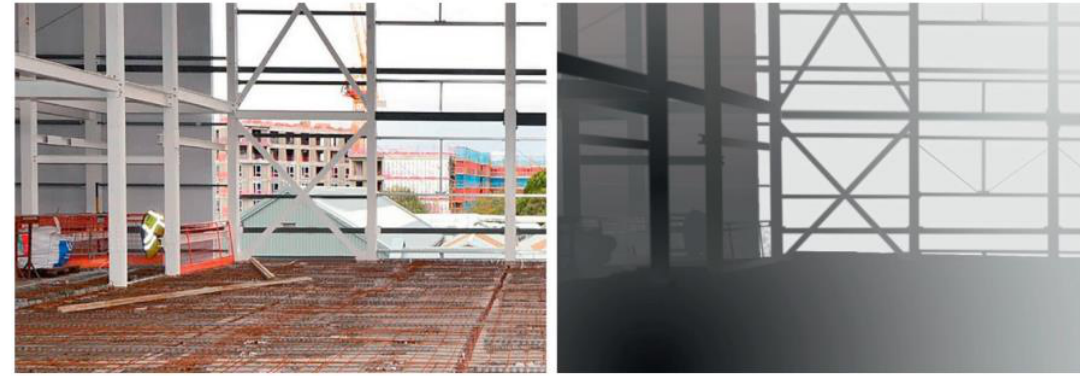
Figure 4. A photo taken from the construction site and its depth map [40].